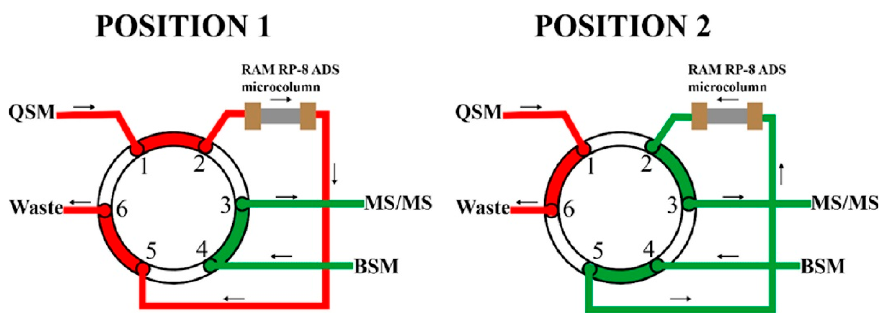
Figure 2. In-tube SPME-MS/MS system using the LC six-port valve from reference [20]. Using two binary pumps allows mobile phases with different compositions and flow rates to be employed during the extraction and chromatographic separation steps. In addition, chromatographic separation can be carried out simultaneously with the cleanup of the extraction capillary column.